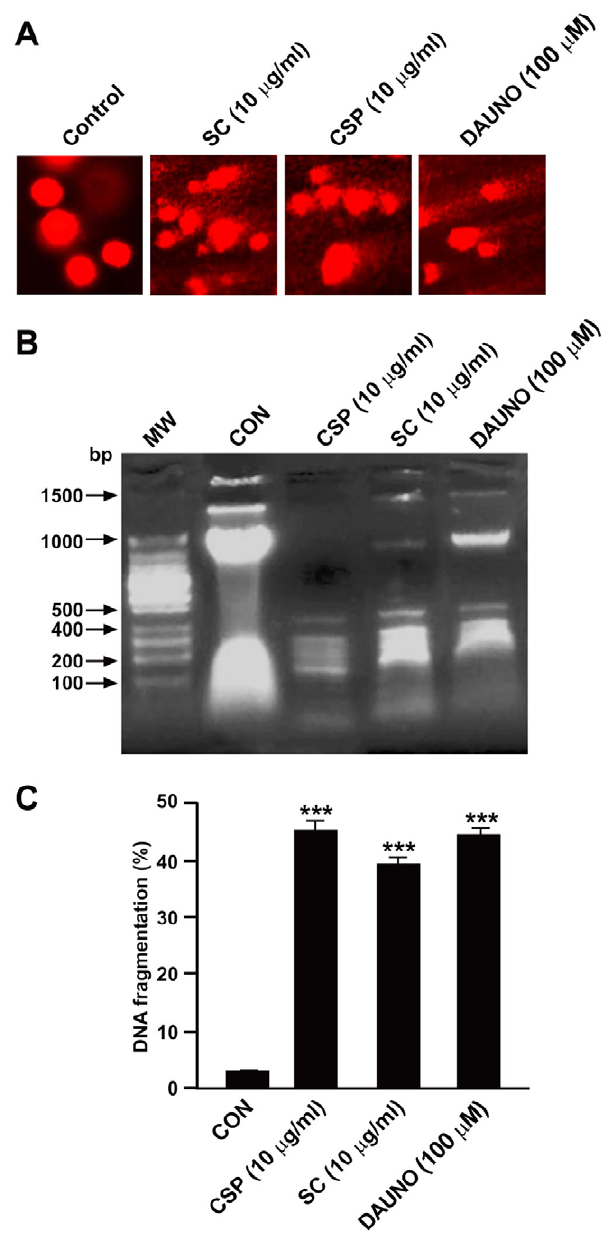
Figure 3. Effect of SC and CSP on DNA fragmentation. The T47D cells were treated with SC (10 m g/ml), CSP (10 m g/ml) or Dauno (100 m M) for 24 h, thereafter DNA fragmentation was analyzed by comet assay (A), agarose gel electrophoresis (B) and diphenylamine assay (C). Basal DNA damage from untreated cells, DNA damage from SC or CSP cells (A). Data are from a single experiment and representative of 50 randomly selected cells stained with ethidium bromide (EtBr). Data illustrated in (B) are from a single experiment and representative of three separate experiments, while data in (C) are expressed as mean 6 S.E.M. of three separate experiments. ***p , 0.001 vs. control (untreated cells).